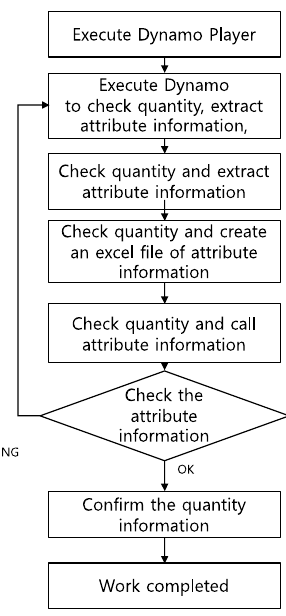
Figure 11. Process flowchart—temporary facilities quantity inspection module.